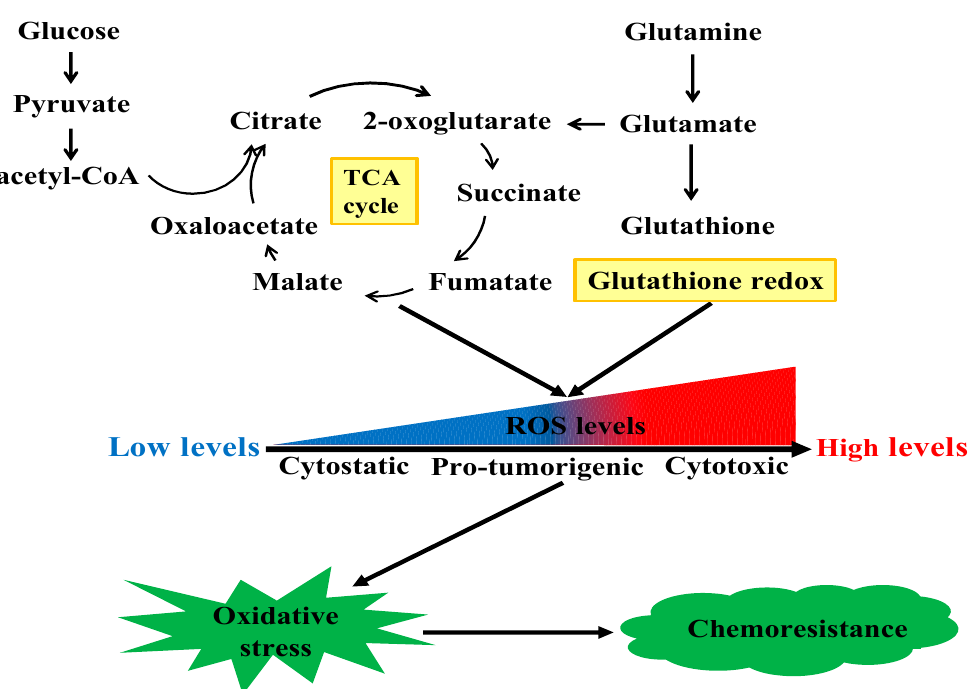
Figure 2. The mechanical illustration of ROS-induced chemoresistance in cancer cells.